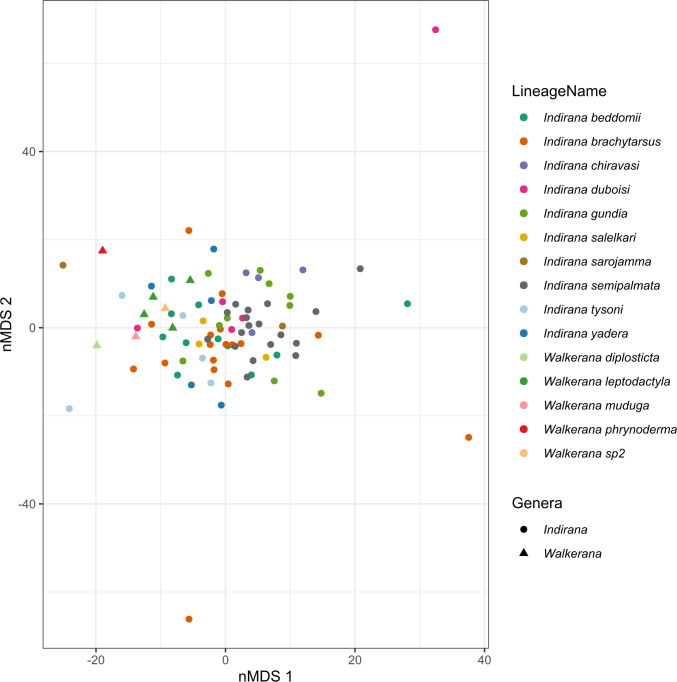
Nonmetric Multidimensional Scaling (nMDS) ordination representing the sampled frogs colored by lineages.nMDS axis 1 explains 55.08% of the variability in morphological composition and nMDS axis 2 explains 28.14%. The ordination suggests that irrespective of their genetic distance, the lineages clustered in morphological space. Refer to lineage numbers in S1 File.